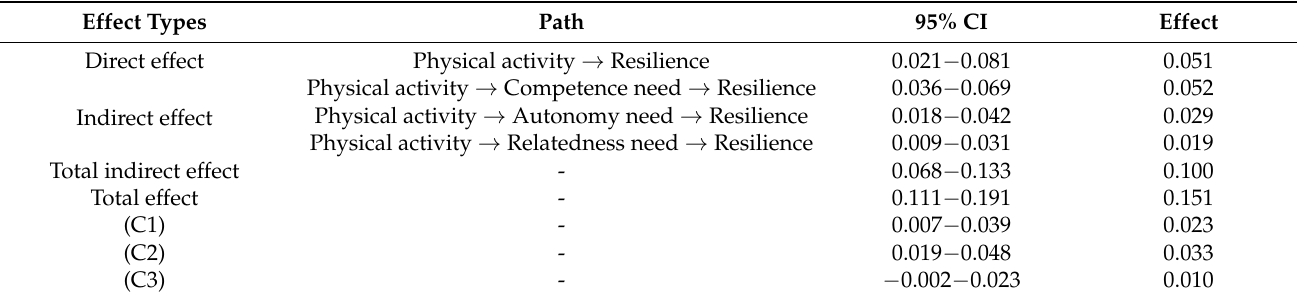
Table 3. Mediating effects of basic psychological needs satisfaction between physical activity and resilience by the PROCESS macro. Demographic variables were controlled as covariances.